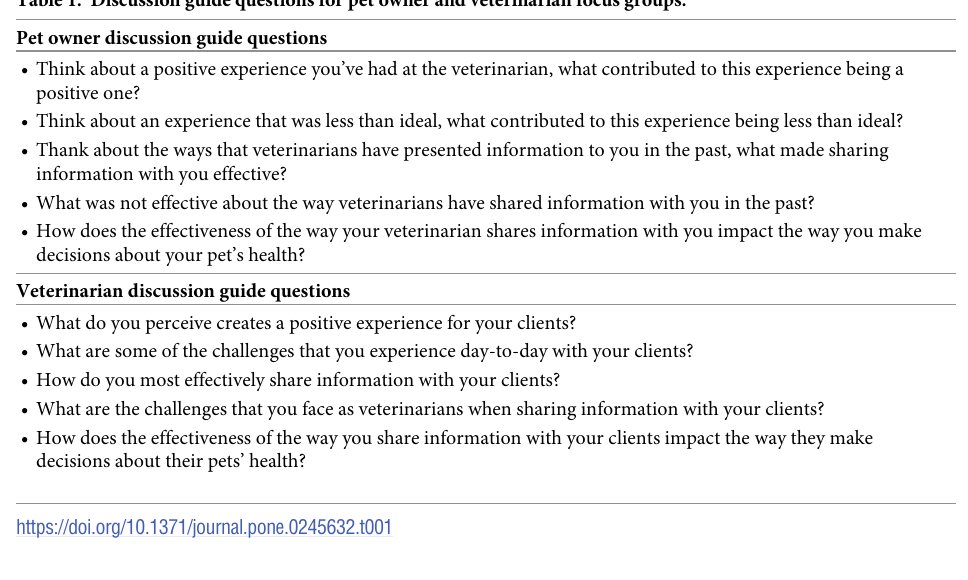
Table 1. Discussion guide questions for pet owner and veterinarian focus